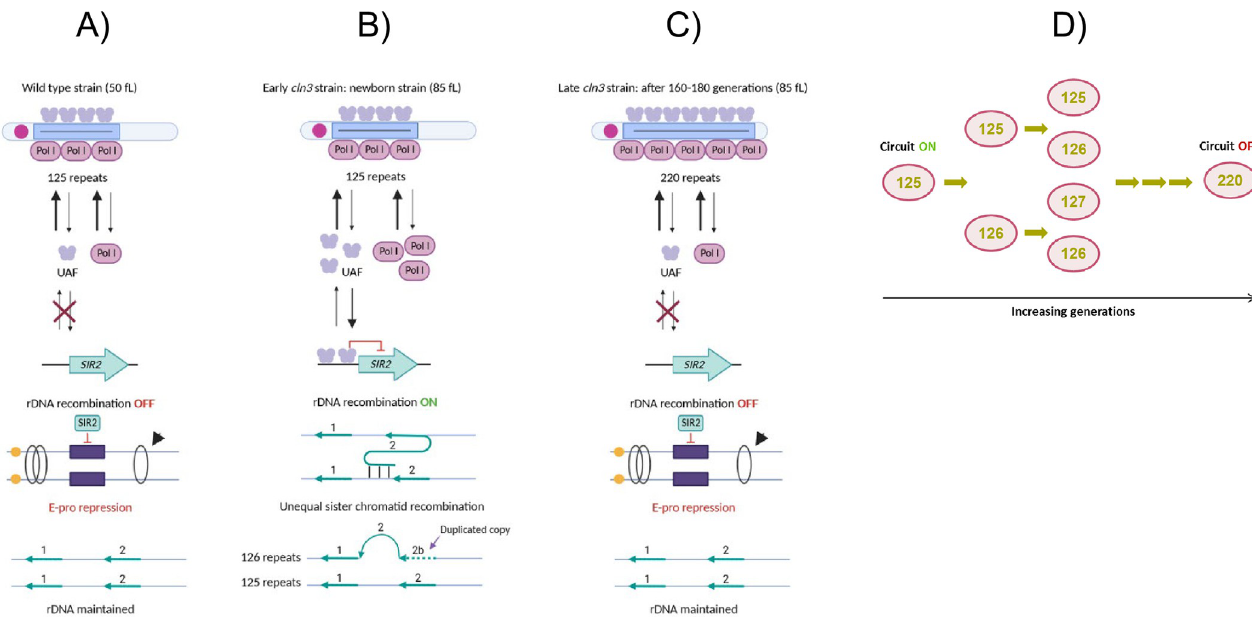
Fig 1. Model for the regulation of the rDNA copy number in the yeast S . cerevisiae by cell volume using the “musical chair” feedback circuit. A,B) In a newly made cln3 strain, the cell volume is 85 fL, which is much bigger than its parental wild type (50 fL). The number of rDNA repeats is, however, the same: 125. As the cellular concentration of most proteins is identical in all cells [21], the number of UAF and RNA pol I molecules should increase proportionally to cell volume and in such a way that in the smaller wild type, the number of UAF molecules is in excess of the rDNA repeats, which leaves many free nucleoplasmic UAF molecules. The UAF also possesses repressor activity for the SIR2 gene promoter which then becomes repressed. The low Sir2 histone deacetylase activity avoids the repression of the recombination in the rDNA locus (see references 16,17 for a more detailed description). The unequal sister chromatid recombination (USCR) works only in a way that it amplifies copies (1 or more) in one of the daughter chromatids [14]. C) When the amplification of the rDNA repeat copy number reaches a number (about 220–250 copies) that sequesters most free nucleoplasmic UAF molecules, the SIR2 promoter becomes derepressed and Sir2 activity blocks USCR to stop rDNA repeat amplification. The rDNA repeat number is then maintained with generations as in a wild type strain. D) The number of repeats grows stepwise from 125 to about 220 copies, on average, in a yeast culture for about 160–180 generations in a heterogeneous population of yeast cln3 cells until the feedback circuit is